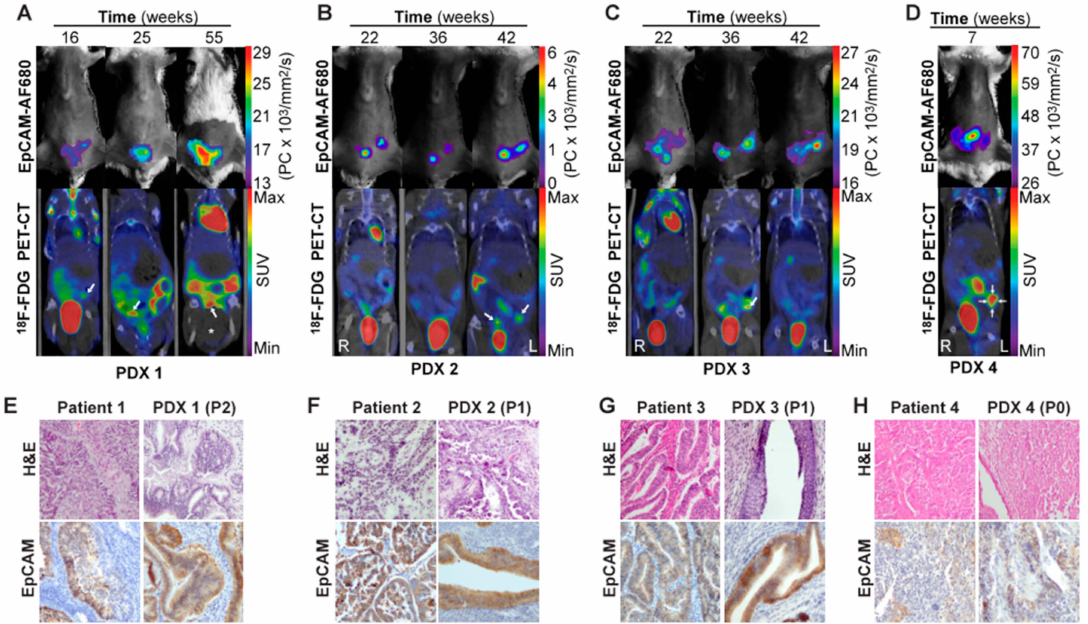
Figure 5. In vivo imaging of tumor growth in PDX models using EpCAM-AF680 NIRF and 18 F-FDG PET / CT. Longitudinal monitoring of uterine tumors of di ff erent histologic types in PDX models using EpCAM-AF680 NIRF and 18 F-FDG PET / CT imaging. Arrows mark probable uterine tumors in PET / CT images ( A – D ). H&E staining demonstrating uterine tumor cells, and positive EpCAM IHC staining of uterine tumors from both donor patients and mouse xenografts (20 × magnification) ( E – H ). Large bladder removed from image for visualization purposes. An uncropped version of this image can be found in Figure S2. Abbreviations: Epithelial cell adhesion molecule (EpCAM), Fluorine-18-fluorodeoxyglucose ( 18 FDG), Hematoxylin and eosin (H&E), Near-infrared fluorescence (NIRF), Patient-derived xenograft (PDX), Positron emission tomography / computed tomography (PET / CT), and Standardized uptake value